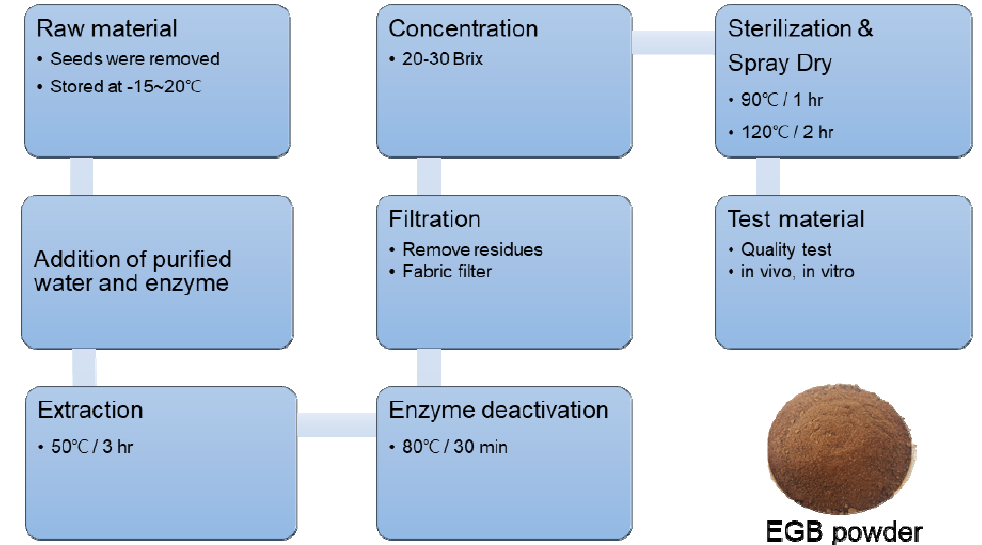
Figure 9. Manufacturing process for the production of enzyme-treated ginseng berry extract (EGB)